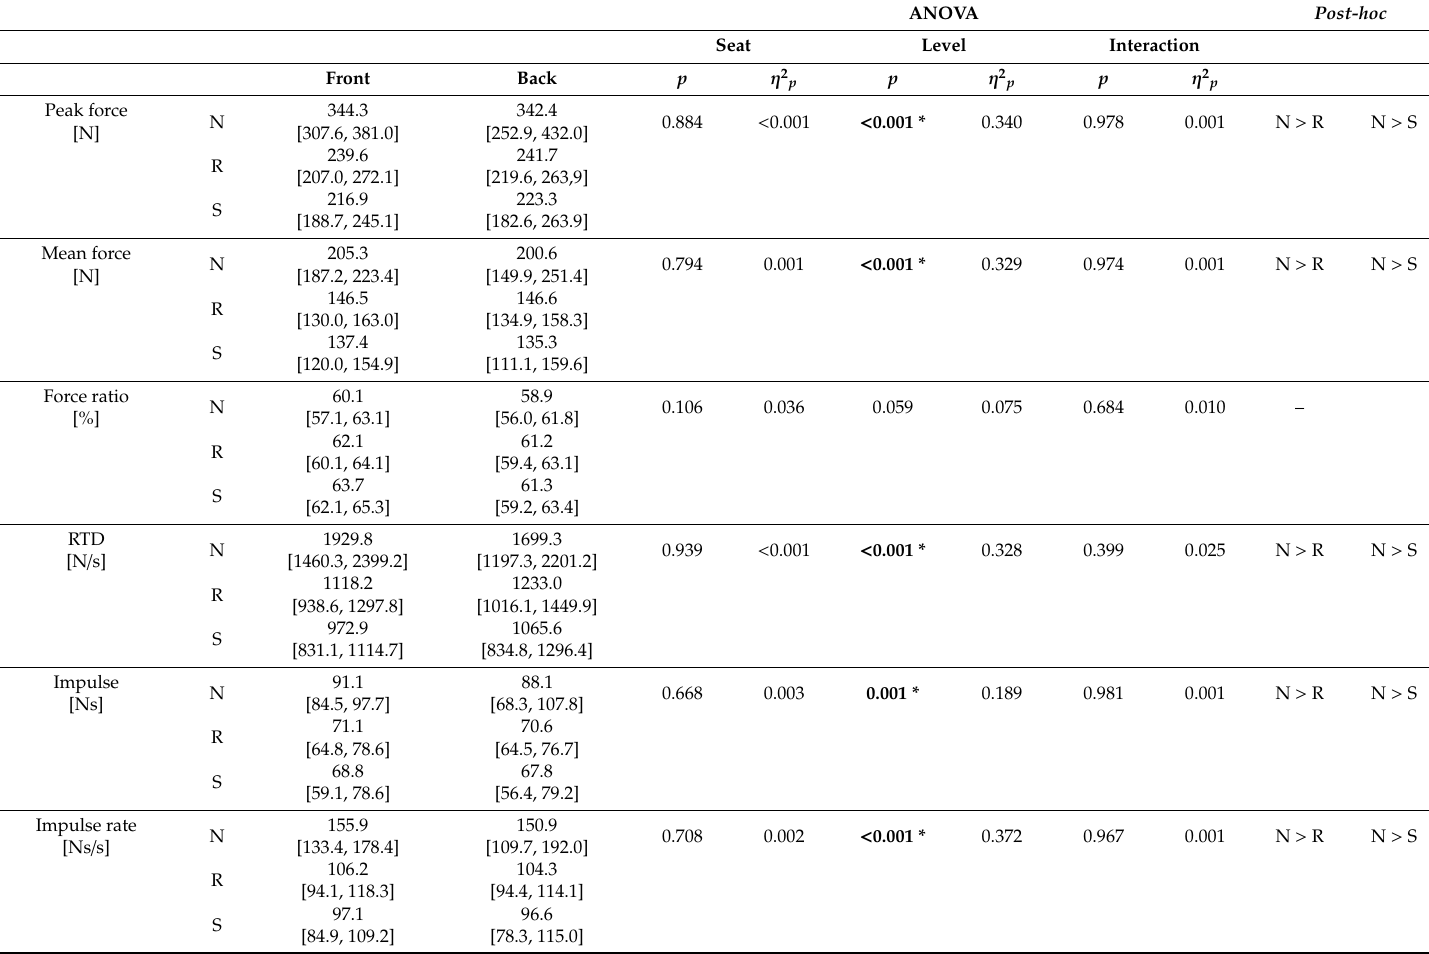
Table 2. Force variables of front and back paddlers of K2 crews during a 200-m maximal e ff ort sprint kayaking. ANOVA